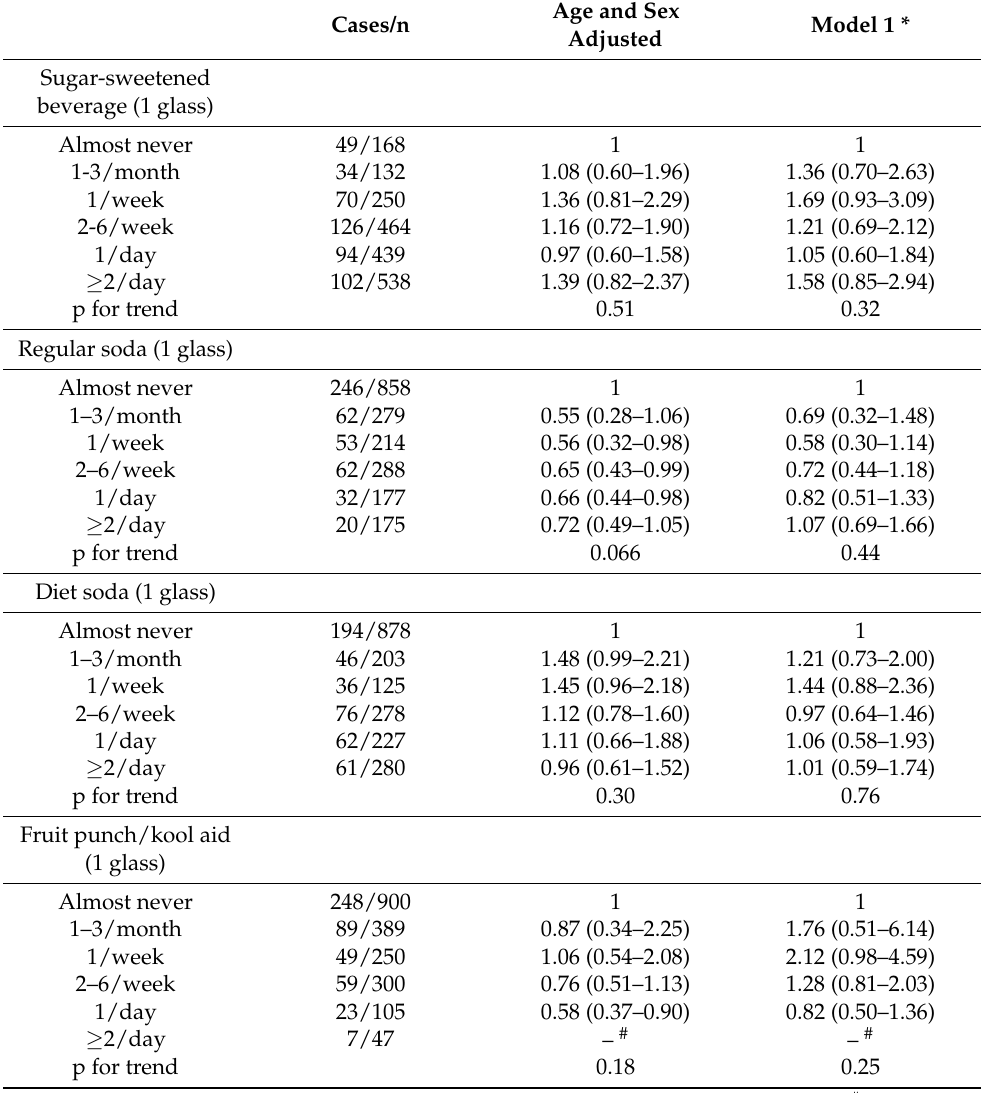
Table 2. Prevalence ratios (95%CI) of coronary artery calcification according to sugar-sweetened beverage consumption in 1991 participants from the NHLBI Family Heart